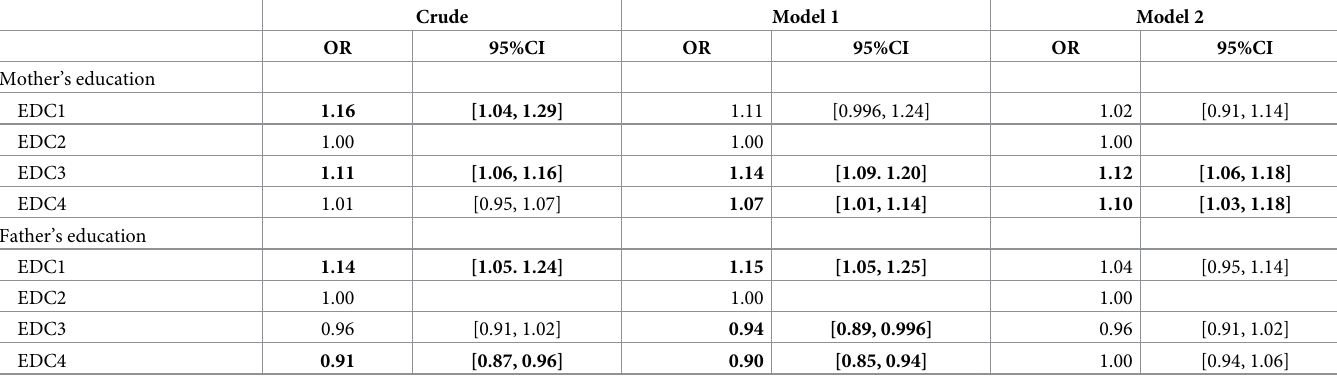
Table 2. Crude and adjusted odds ratios for wheezing in multilevel logistic regression analysis (multiple imputation, N = 69,067).